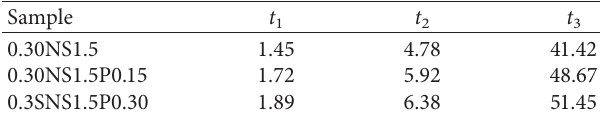
Table 6: The hydration separation period time of different SAP content cement pastes (h).